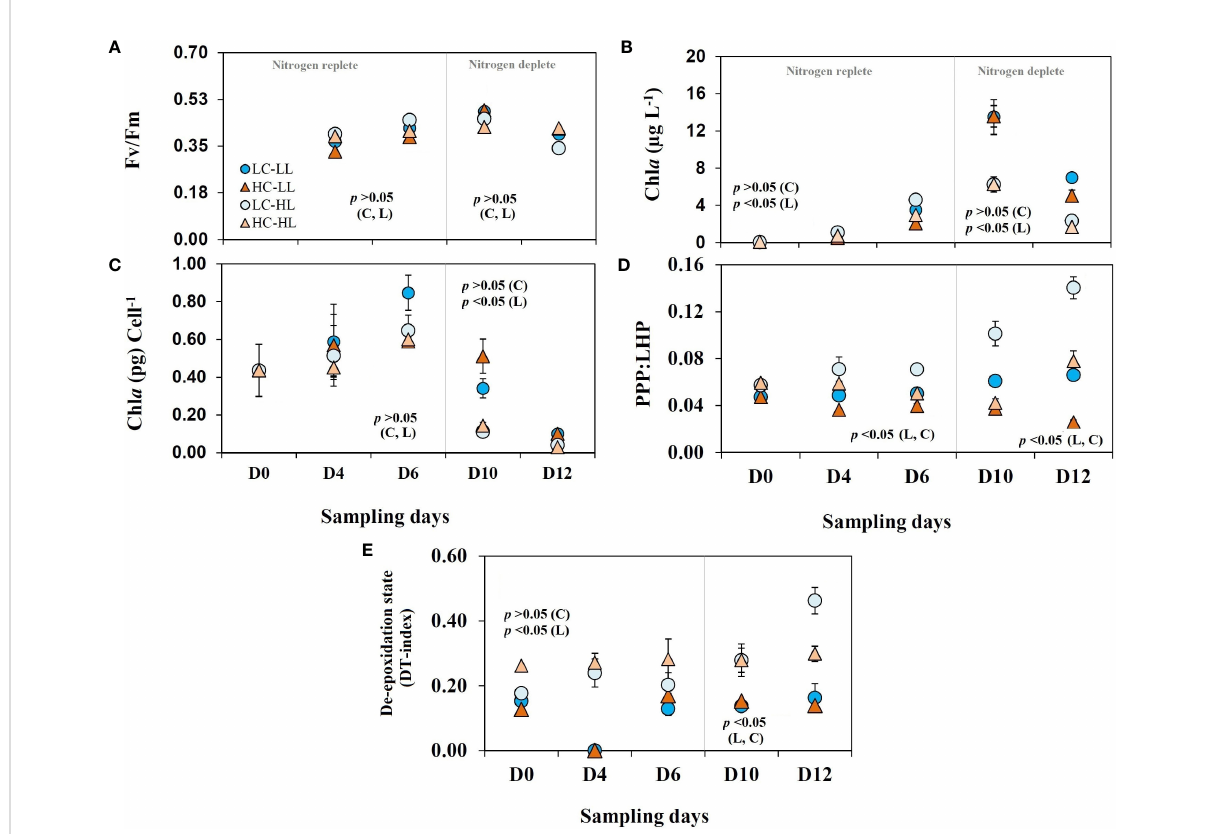
FIGURE 3 Photophysiogy and pigment signature of C . gelidus over the experimental period under two different light conditions [low light (LL) = 50 µmol m -2 s -1 , high light (HL) =100 µmol m -2 s -1 ] and CO 2 levels [low CO 2 (LC) ≈ 240 µatm and high CO 2 (HC) ≈ 900 µatm levels]. (A) Fv/Fm values; (B) Chl a contents; (C) Chl a contents per cell; (D) the ratio between photoprotective and light harvesting pigment contents (PPP : LHP) and (E) diatoxanthin index [DT/(DD+DT)] (n =3; ± SD). The level of signi fi cance ( p -values) related to CO 2 and light levels are shown as C and L, respectively. The gray line demarcates the nitrogen replete and deplete